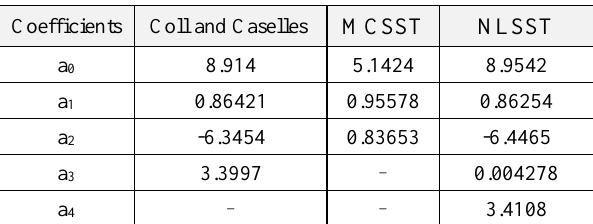
Table 2. Estimated coefficients for MCSST, NLSST and Coll and Caselles algorithms